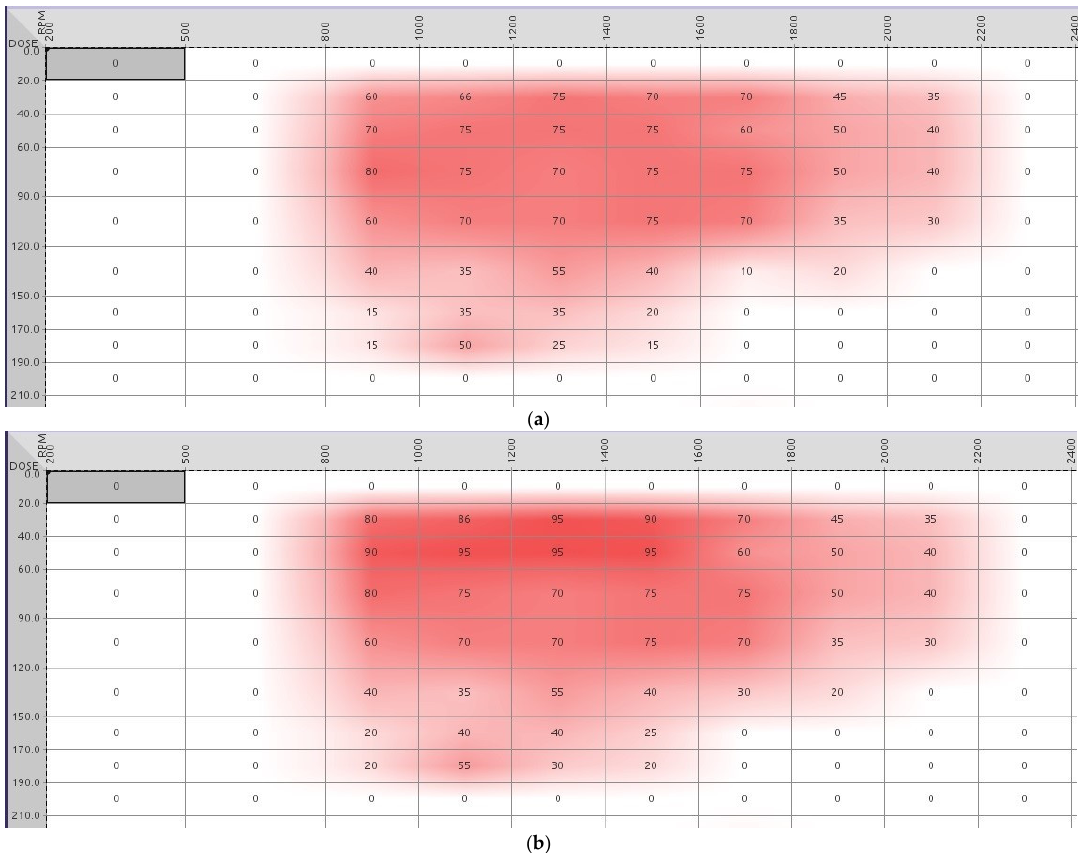
Figure 17. Comparison of the results of tuning the map of conversion of diesel fuel to gas fuel in terms of: ( a ) attempts were made to reduce the impact of errors, and ( b ) where the errors listed in the paper are combined (authors’ source).